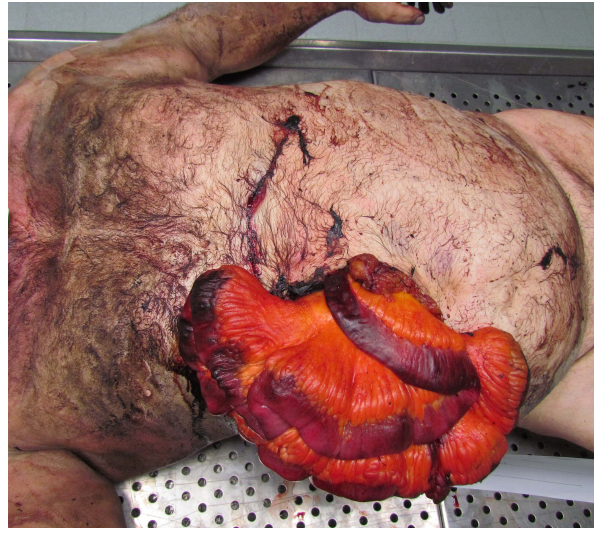
Fig. 2. Case 2. Large cut wound with protruding intestinal loops from the abdomen.